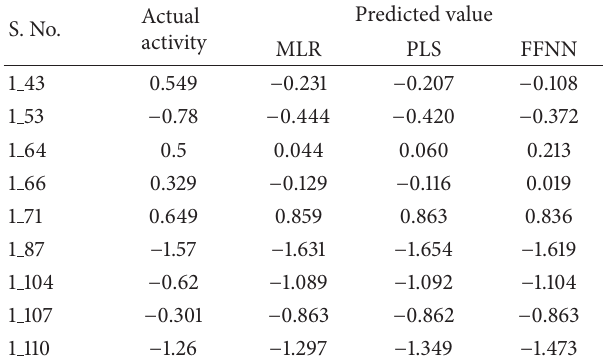
Table 6: Actual and predicted activity data of derivatives obtained from multivariate analysis for test set of breast cell line.